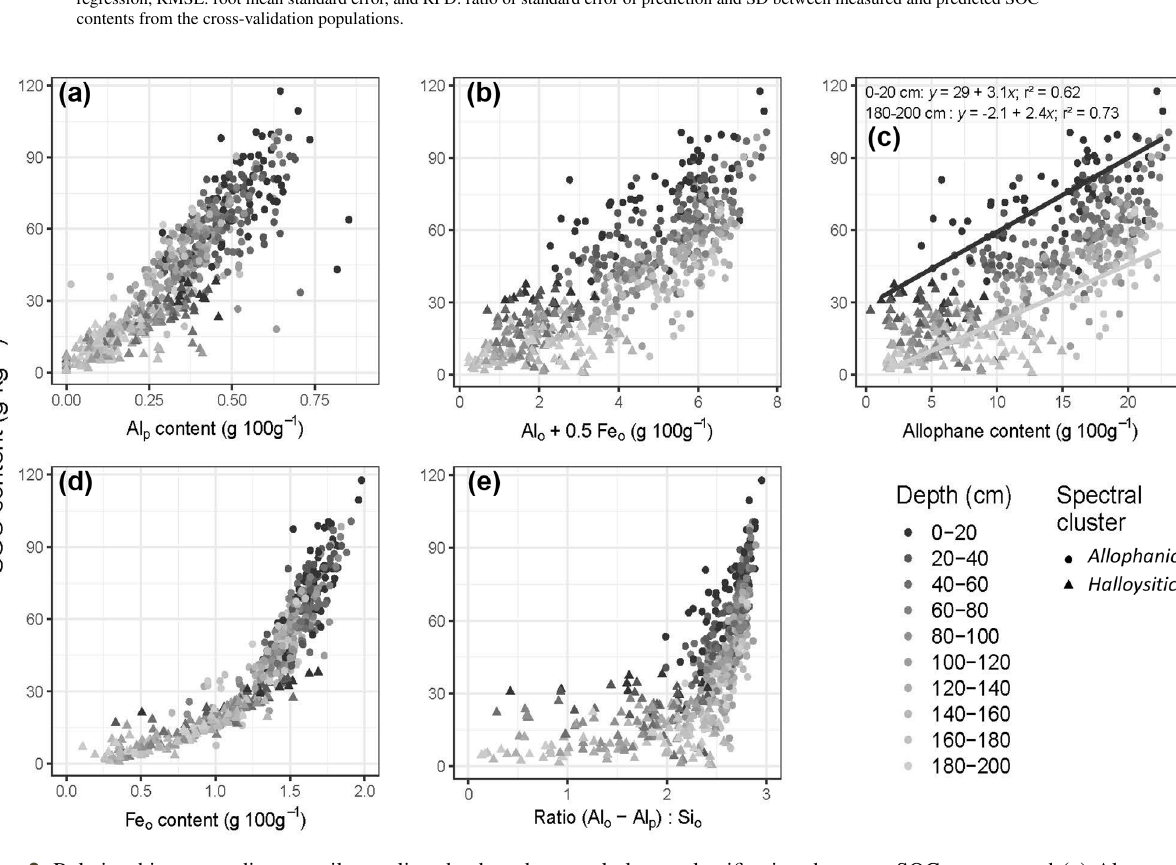
Figure 6. Relationships, according to soil-sampling depth and spectral-cluster classification, between SOC content and (a) Al p content; (b) Al o + 0 . 5Fe o index; (c) allophane content (showing two linear regressions on results for samples from the 0–20cm depth and the 180– 200cm depth); (d) Fe o content; and (e) Al : Si